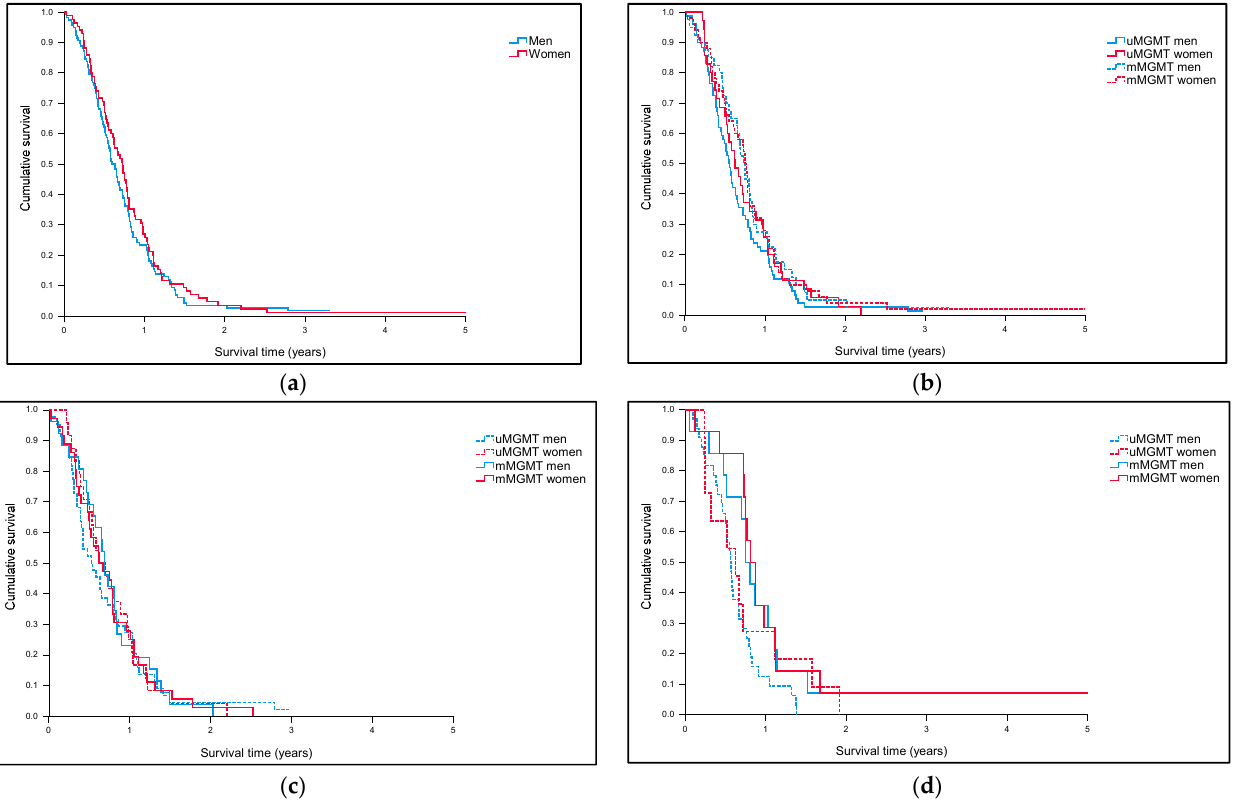
Figure 1. Overall survival in the NORDIC-trial ( a ) for men ( n = 203) vs. women ( n = 139) in the whole cohort ( p = 0.37). ( b ) For men ( n = 117) vs. women ( n = 86) according to MGMT status ( p = 0.40). ( c ) For men ( n = 70) vs. women ( n = 61) in the RT-arms ( p = 1.0). ( d ) For men ( n = 47) vs. women ( n = 25) in the TMZ-arm of the trial ( p = 0.056).